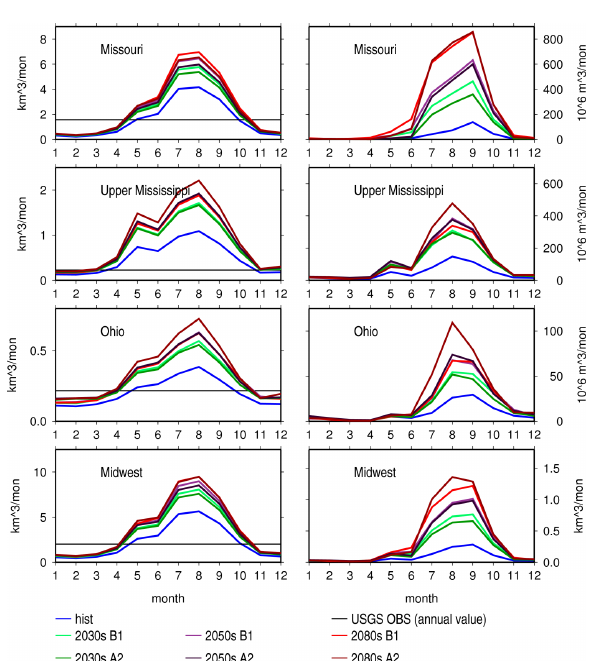
Figure 9: Monthly average of total water demand (left), and supply deficit (right) over the three regions and over the 2 entire domain for different time periods. 3 Fig. 8. Monthly average of total water demand (left), and supply 4 deficit (right) over the three regions and over the entire domain for different time